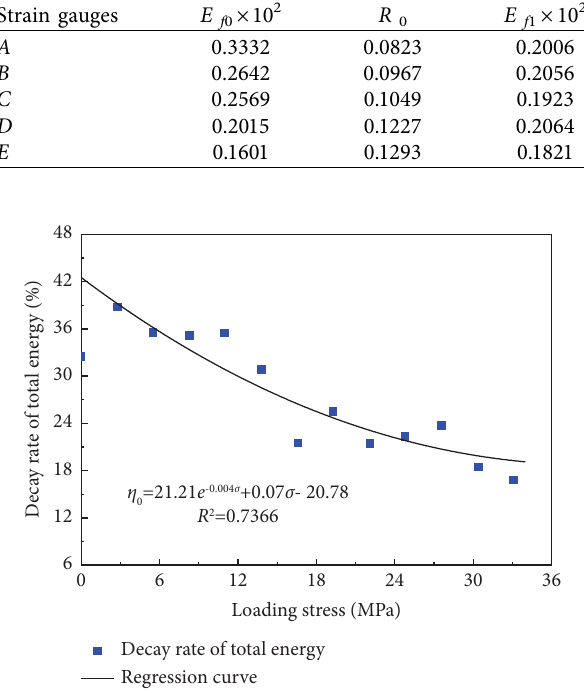
Figure 9: Relation between decay rate of total energy and loading stress.